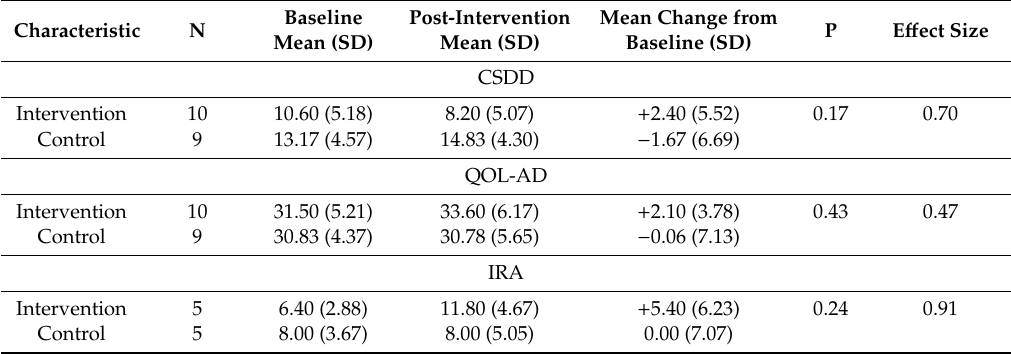
Table 7. Mean pre- and post-intervention scores, mean change scores and statistical